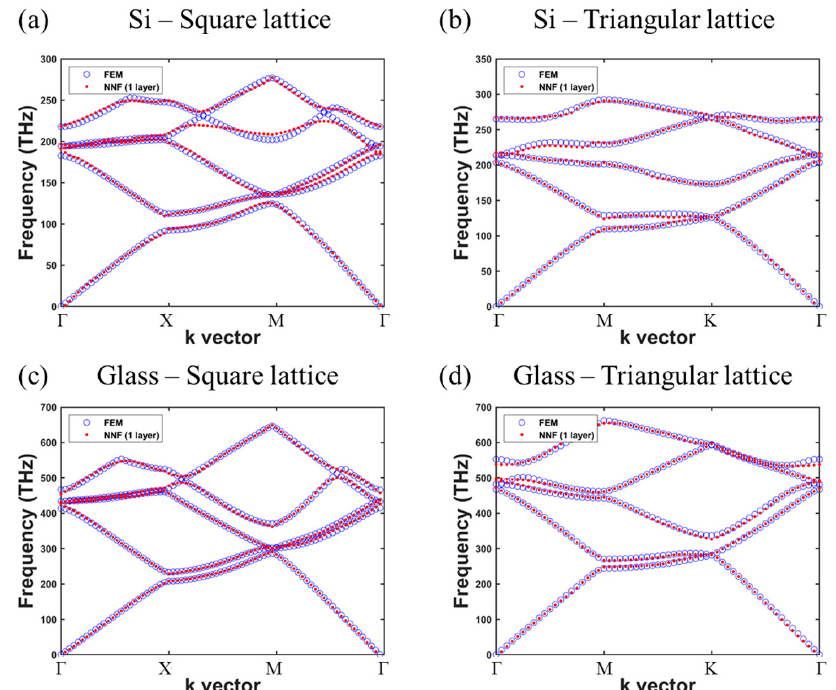
Figure 6. FEM-calculated (blue circles) and predicted (red dots) band structures of PCs made of Si in ( a ) square lattice and ( b ) triangular lattice and glass in ( c ) square lattice and ( d ) triangular lattice with r/a = 0.32 and 25 neurons in the hidden